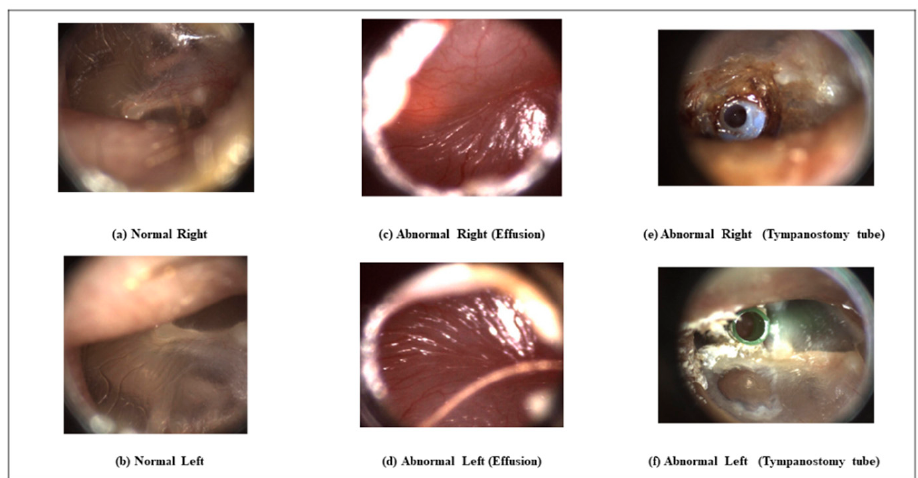
Figure 2. Preprocessed image example from each category: ( a ) Normal Right, ( b ) Normal Left, ( c ) Abnormal Right (Effusion) ( d ) Abnormal Left (Effusion), ( e ) Abnormal Right (Tympanostomy tube), and ( f ) Abnormal Left (Tympanostomy tube).